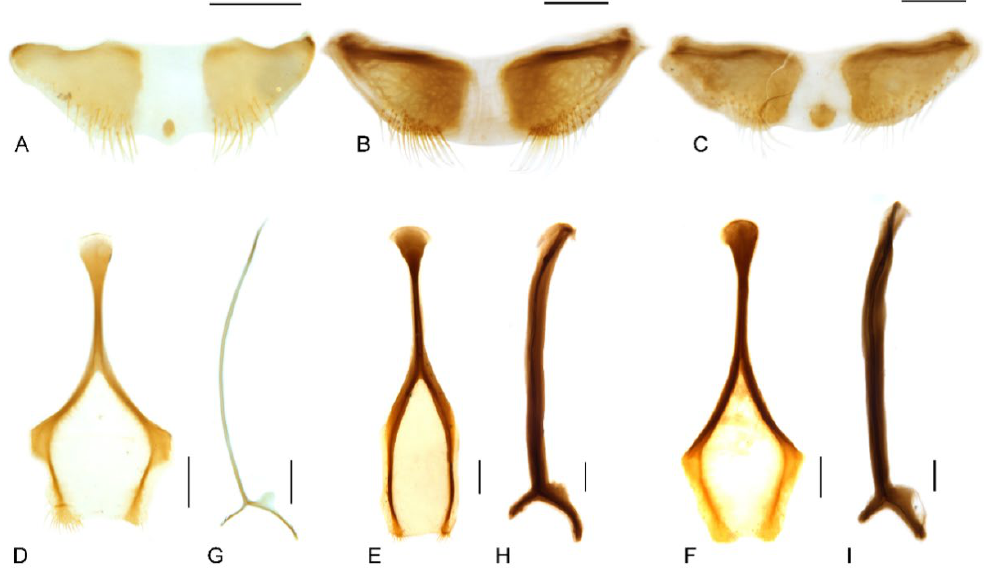
Figure 8. Diagnostic characters of terminalia of Miltotranes : ( A ) M. prosternalis , abdominal sternite VIII of male, dorsal view; ( B ) M. subopacus , ditto; ( C ) M. wilsoni sp. n., ditto; ( D ) M. prosternalis , sternite VIII of female, dorsal view; ( E ) M. subopacus , ditto; ( F ) M. wilsoni sp. n., ditto; ( G ) M. prosternalis , spiculum gastrale, dorsal view; ( H ) M. subopacus , ditto; ( I ) M. wilsoni sp. n., ditto. Scale bars: 0.2 mm.